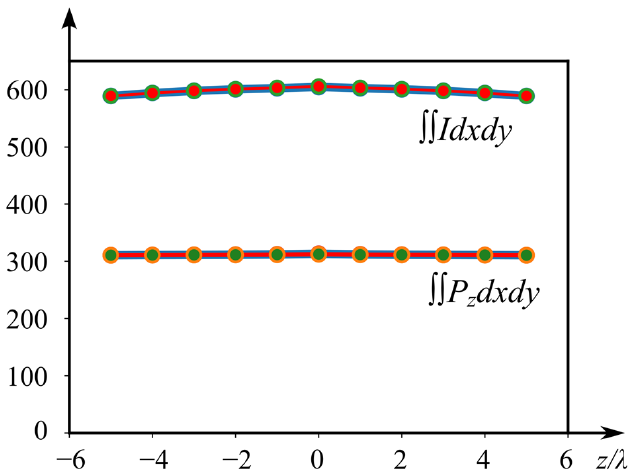
Figure 2. Dependence of the intensity and the longitudinal component of the Umov–Poynting vector, integrated over the transverse plane, on the distance to the focus z . The upper curve is the total intensity(power) and the lower curve is the total longitudinal power flow. The calculation parameters were the same as in Figure 1. The graphs show the curves for n = 1 and n = 3, but they almost coincide with each other. It was assumed that the distribution of the focused light was uniform (| A ( θ )| ≡ 1). In this case, the total energy was 2 π f 2 ≈ 628 µ m 2 . Numerically obtained values were (cid:82) (cid:82) Idxdy ≈ 600 µ m 2 . The theoretical value of the total longitudinal power flow approximately equal to (cid:82) (cid:82) P z dxdy ≈ 310 µ m 2 was π f 2 ≈ 314 µ m 2 . Numerically obtained values were approximately equal to